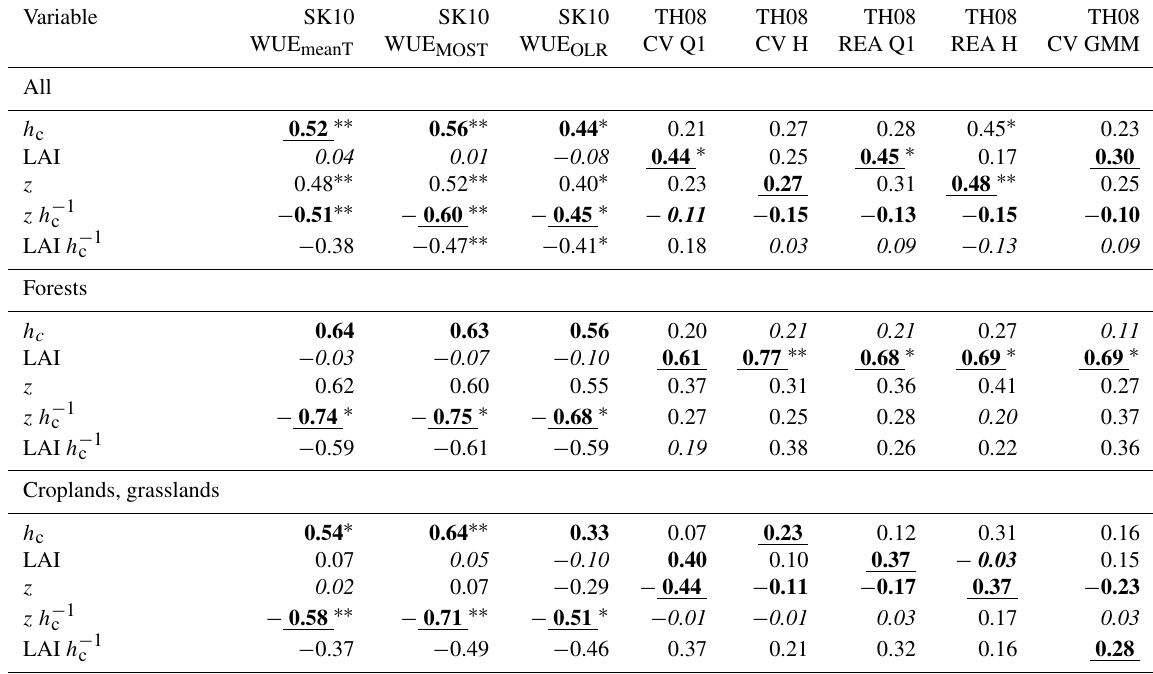
Table 2. Correlation coefficients between the partitioning performances of each method version regarding HiR GPP (see text for description) and study site characteristics ( h c : canopy height; LAI: leaf area index; z : measurement height) considering different sets of sites: all, only forest, or only cropland and grassland sites. Bold lettering indicates highest positive and highest negative correlation. Underlined letter- ing indicates highest magnitude of correlation and italic lettering lowest magnitude of correlation. Also, the statistical significance of the correlations is indicated with ∗ p ≤ 0 . 1 and ∗∗ p ≤ 0 .